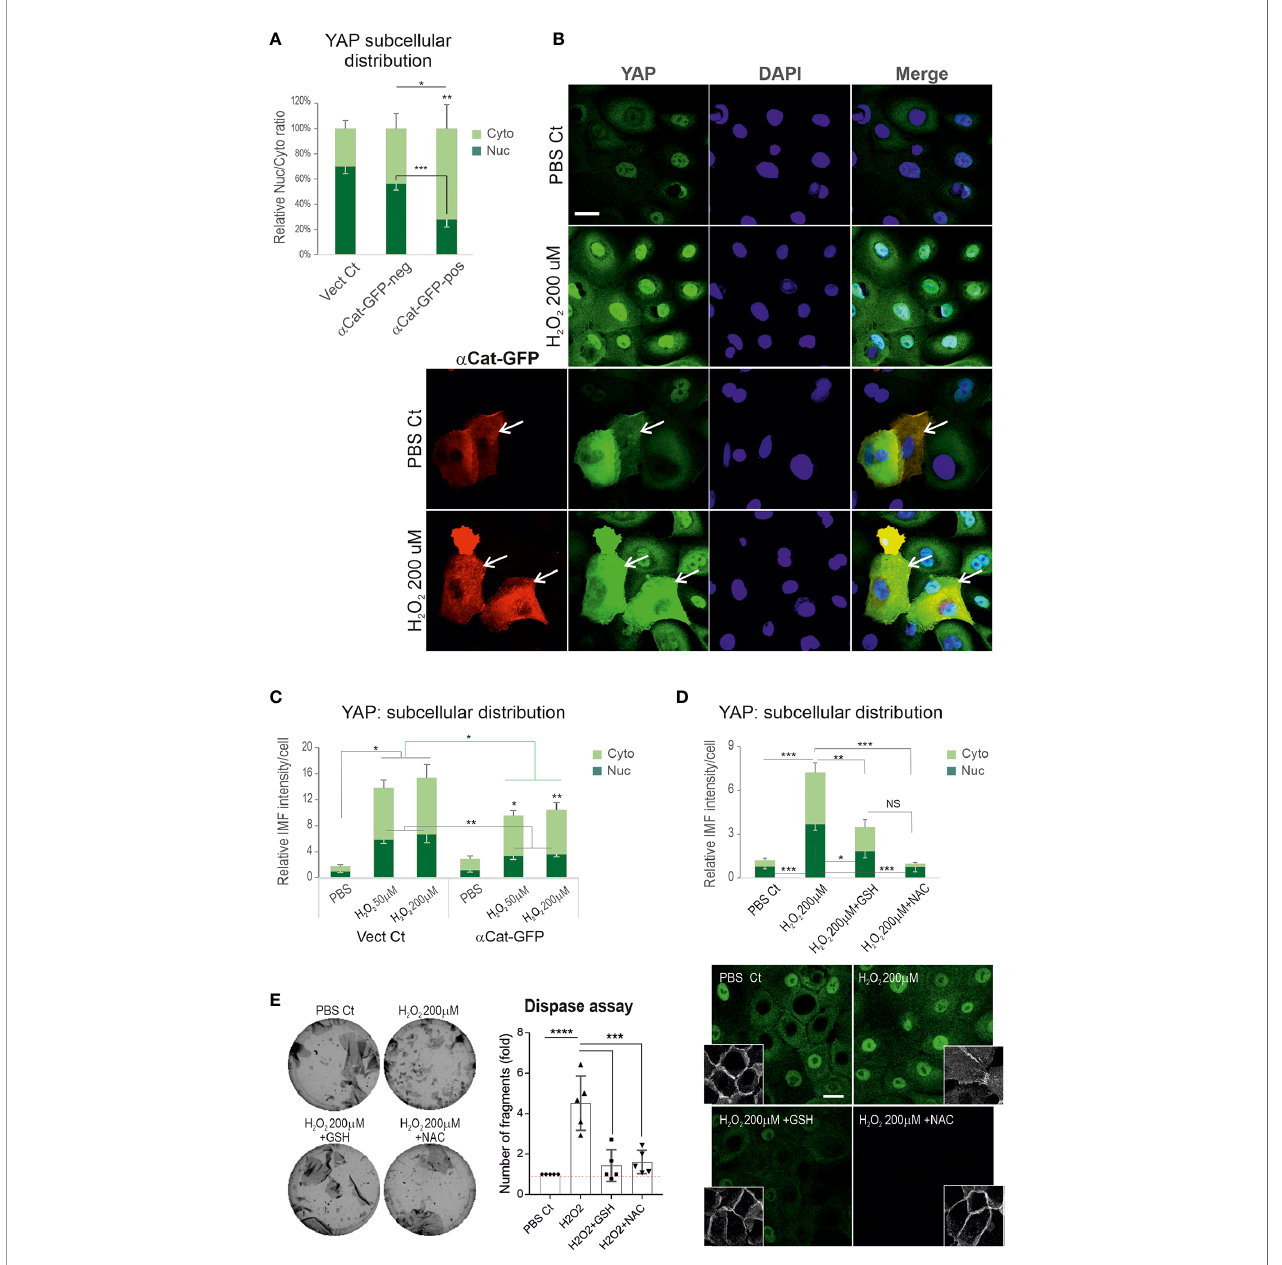
FIGURE 6 | Expression of exogenous a -catenin or treatment of keratinocytes with antioxidants can rescue H 2 O 2 inducted YAP nuclear accumulation with concomitant enhancement of the cell junctional integrity. (A) Analysis of YAP expression and distribution in GFP+ (indicating a -catenin-GFP transfection) and GFP- cells ( a -catenin-GFP un-transfected cells), respectively. Cells transfected with empty vector served as the control. Expression of a -catenin-GFP caused a reduction of nuclear YAP. (B) Confocal images of a -catenin-GFP plasmid transfected or mock control N/TERTs seeded at 2.5x10 5 per well to reach ~70% con fl uent densities. Next day cells were treated with or without H 2 O 2 (only one dosage was displayed) for 2 hours and doubled labeled for YAP (green) and GFP (red). YAP nuclear exclusion was evident in cells with a -catenin-GFP expression. (C) Image quantitation in different conditions shown in B (n=5 fi elds/coverslip, representative of 2 independent experiments, Mean ± SEM, normalized to PBS control nuclear signal that was arbitrarily set as 1). The green line indicates comparison of total fl uorescent intensity between control and a -catenin-GFP transfected cells, whereas the black lines were comparisons for cytoplasmic (Cyto) and nuclear (Nuc) signals, respectively. (D) YAP expression in cells of ~70% con fl uence, treated with one dosage of H 2 O 2 in the presence and absence of GSH (10 m M) and NAC (2mM) for 2 hours (n=13, pooled data from 3 independent attempts, Mean ± SEM). Cells were treated with antioxidants 1 hour before H 2 O 2 addition. Confocal images for YAP and Dsg3 (inserts, stained with 5H10 mAb) were displayed underneath. (E) Dispase assay in different conditions as shown in D. Cells of 100% con fl uence grown in KGM were treated with H 2 O 2 in the presence and absence of GSH (10 m M) and NAC (2 mM) for 4 hours (n=5, pooled from 3 independent experiments, with one in triplicate, Mean ± SD),. One-way ANOVA was used to obtain all p values. *p<0.05, **p<0.01, ***p<0.001, ****p<0.0001, and NS indicates no signi fi cance. Scale bars,